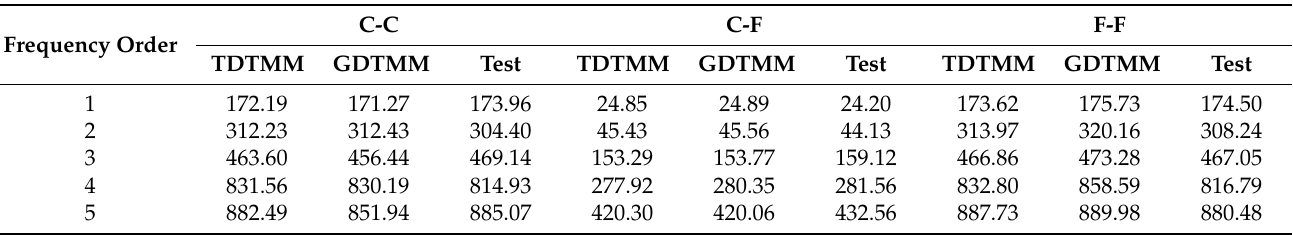
Table 9. Natural frequencies (Hz) of the beams of the experimental models for three boundary